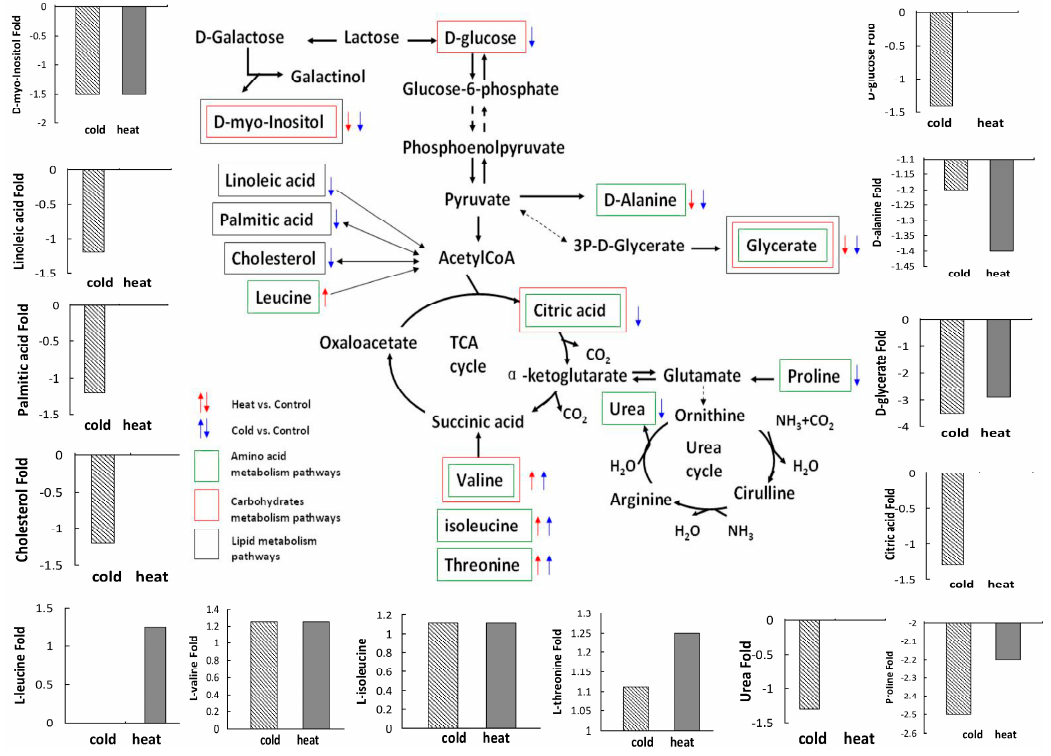
Figure 1 : An overview of metabolic imbalances in rheumatoid arthritis (RA) patients with cold and heat patterns. A schematic representation of amino acid, carbohydrate and lipid metabolism in the center, showing representative metabolite changes connected to the cold pattern and heat pattern of RA patients. The direction of the arrows represents the regulation direction of metabolites; the red arrows represent metabolites in heat pattern RA compared to healthy controls; the blue arrows represent metabolites in cold pattern RA compared to healthy controls. The textboxes outside the molecules represent different types of metabolic pathways: green represents amino acid metabolism; red represents carbohydrate metabolism; and black represents lipid metabolism.